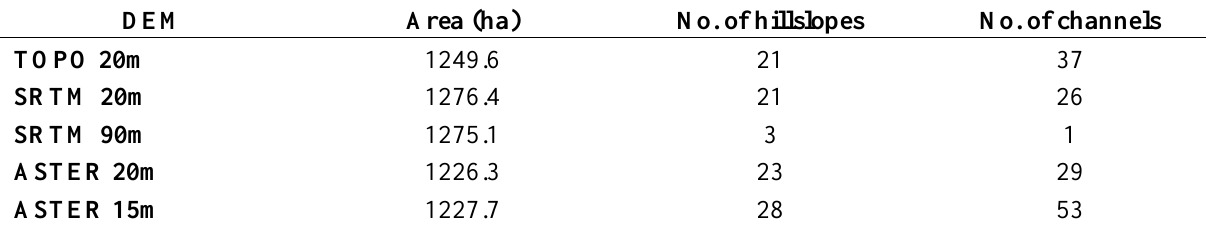
Table 3. Total watershed area, number of hillslopes and flow channels as represented by different